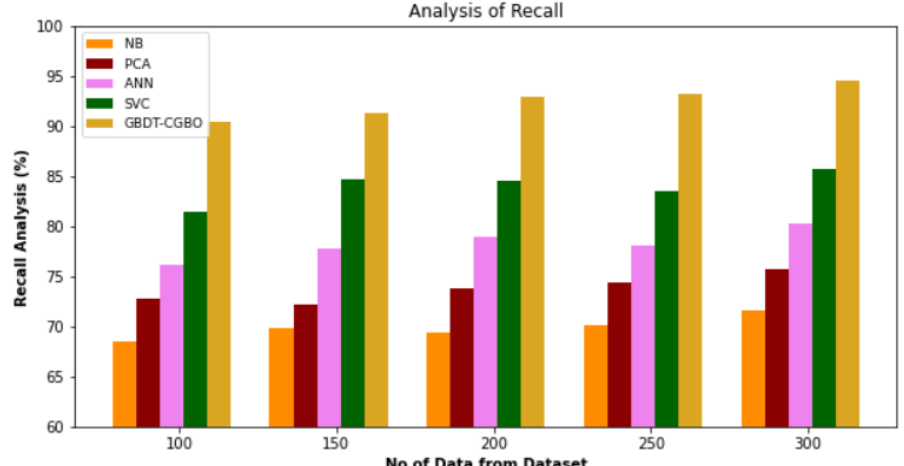
Figure 3. Recall Analysis of GBDT-CGBO method with existing system.